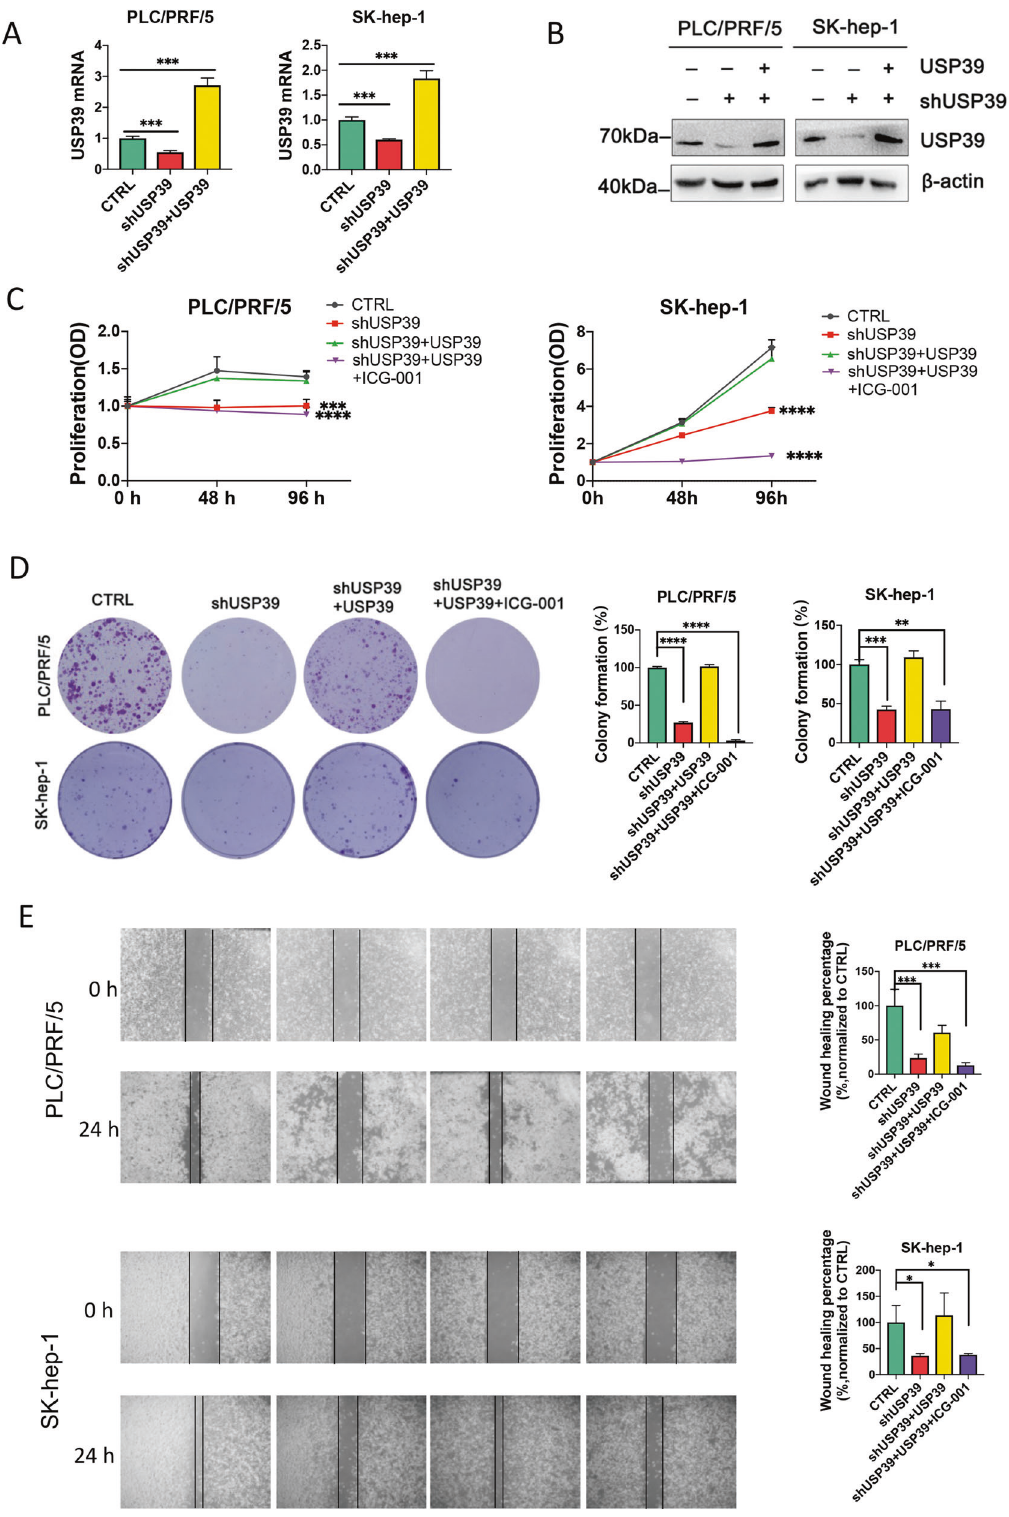
Fig. 1 USP39 increases proliferation and migration of HCC through the wnt signaling pathway. A The expression of USP39 mRNA was analyzed by RT-PCR in PLC/PRF/5 and SK-hep-1 cells. B Western blot con fi rmed the expression of USP39 after cells were knocked down and overexpressed C The effects of USP39 on the proliferation of HCC cells (PLC/PRF/5 and SK-hep-1 cells) were examined by MTT assay in the presence or absence of ICG-001. D Colony formation assays were performed in HCC PLC/PRF/5 and SK-hep-1 cells (The colony numbers were normalized to controls and expressed as a percentage). E Wound-healing assays were performed to determine the effect of USP39 on HCC cells (PLC/PRF/5 and SK-hep-1 cells) migration in the presence or absence of ICG-001. All the data are representative of at least three independent experiments and presented as the means±SD. (* p < 0.05; ** p <0.01; *** p < 0.001; **** p < 0.0001 v.s. control by one-way ANOVA /two-way ANOVA or Student ’ s t -test).